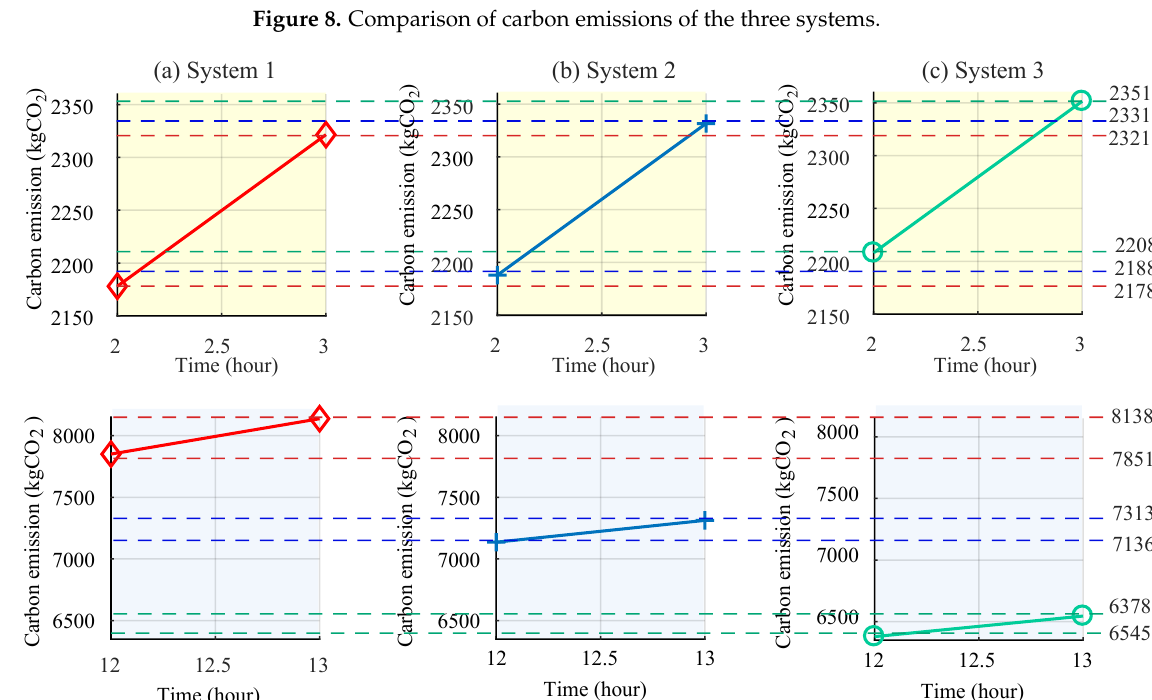
Figure 9. Comparison of typical periods of the three systems.